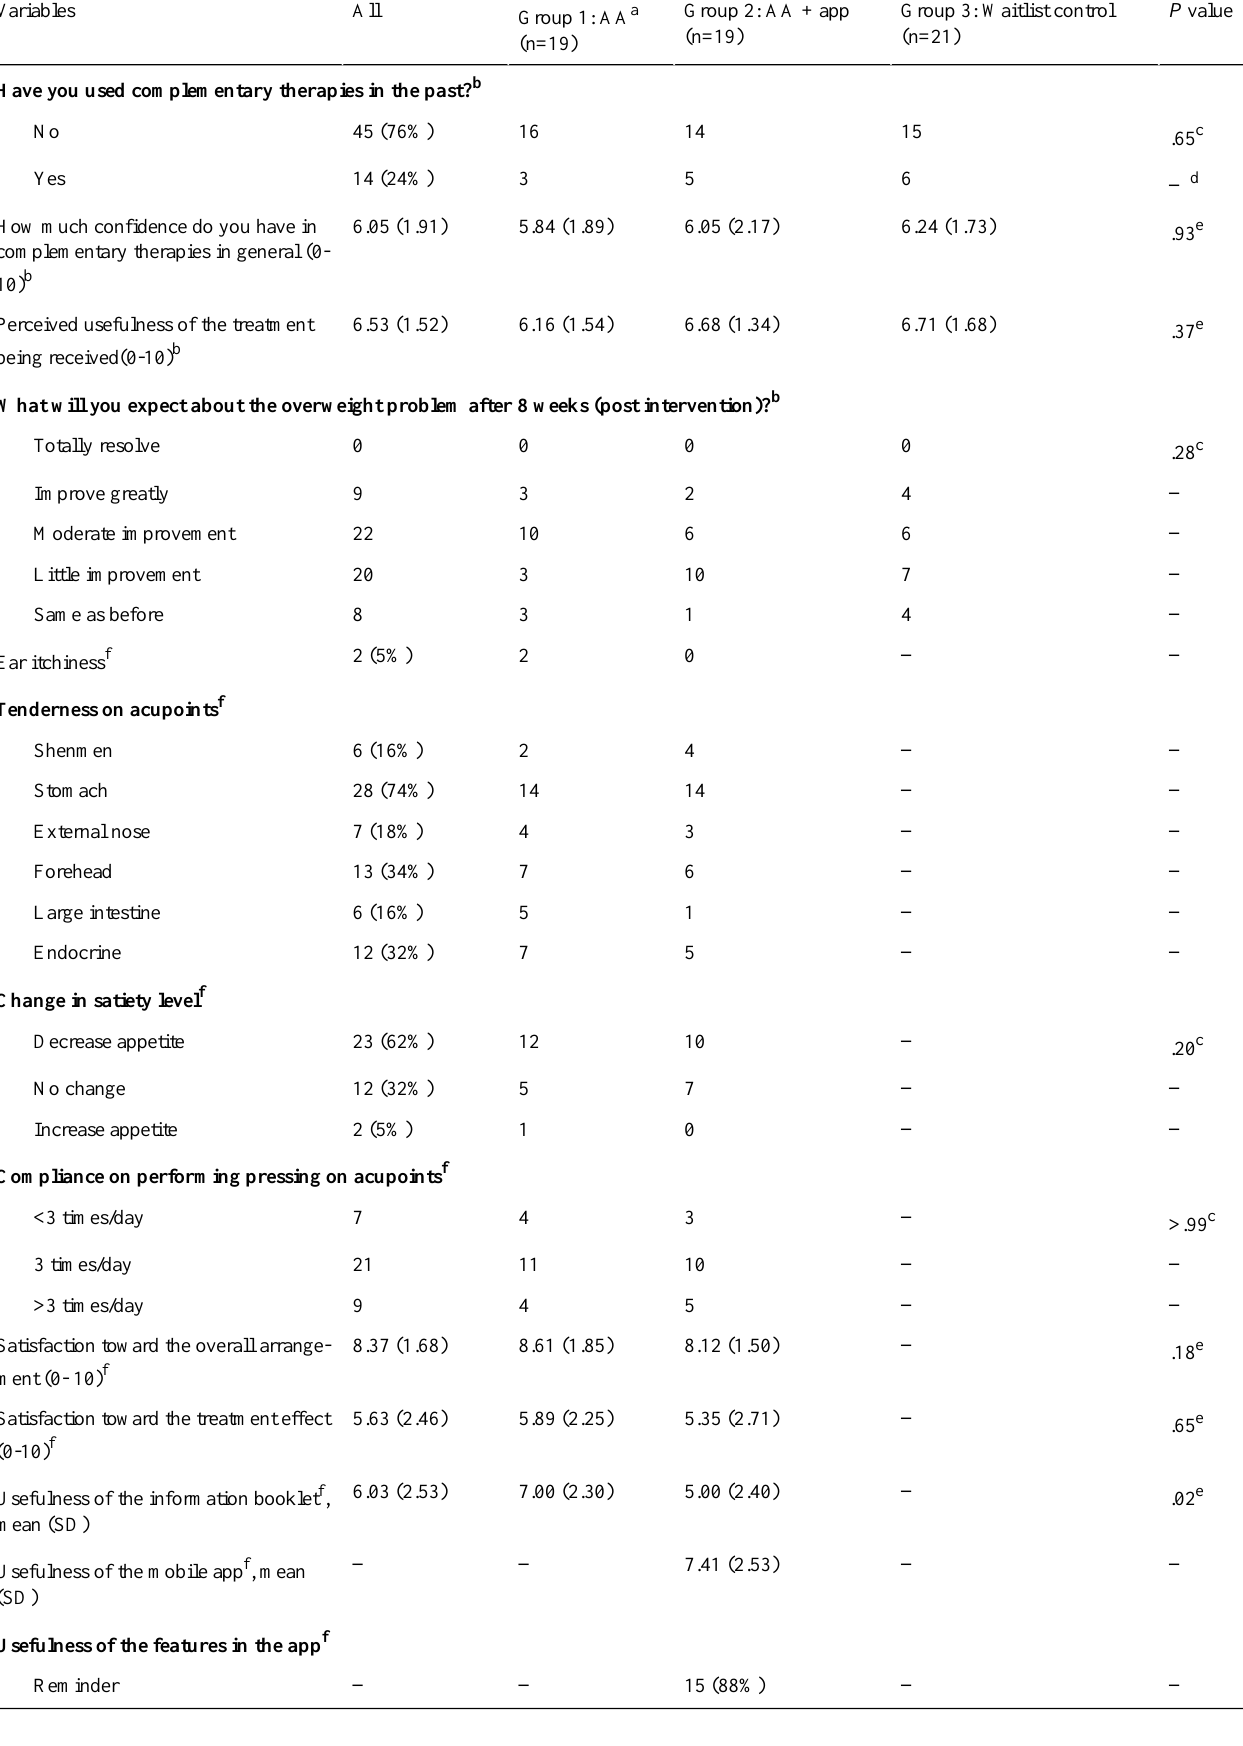
Table 2. Reported adverse effects, expectations, and satisfaction toward the therapy (N=59).